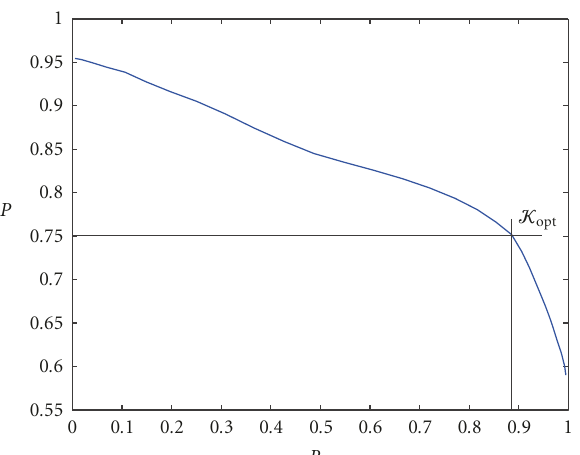
Figure 11: ROC curve of the image cropping procedure.